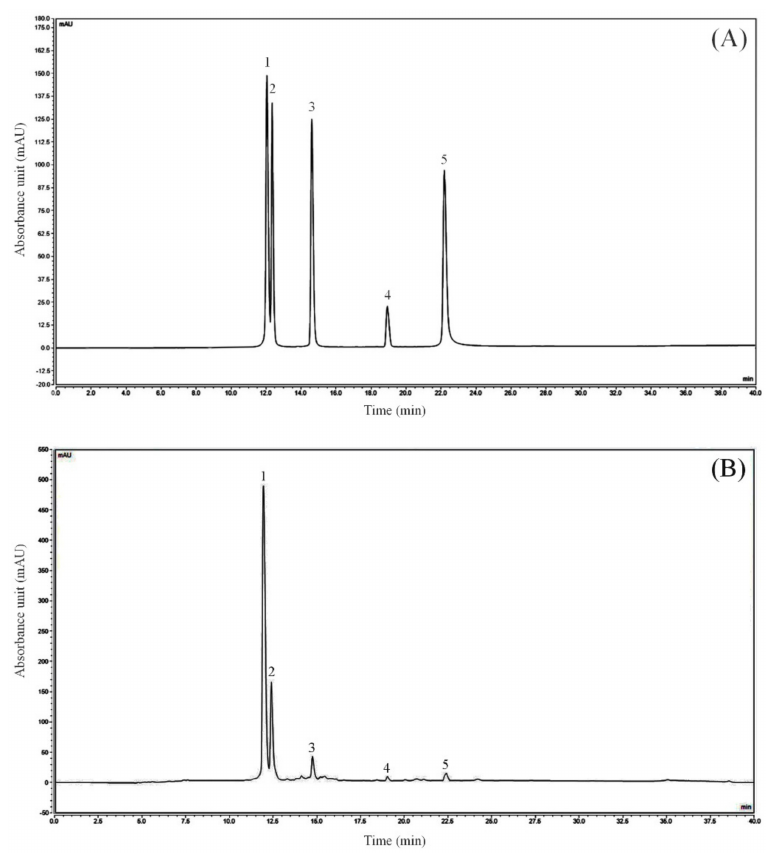
Figure 1. Flavonoids constituents of lotus leaves. ( A ) Standard chromatograms; ( B ) Lotus leaves flavonoids chromatograms. 1: kaempferitrin; 2: hyperoside; 3: astragalin; 4: phloridzin; 5: quercetin.